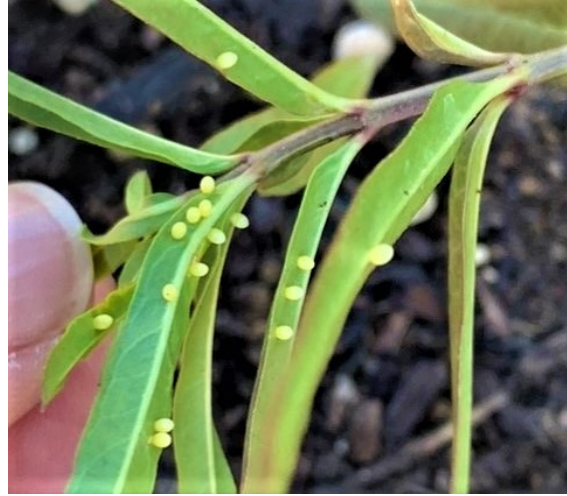
Figure 3. High-density oviposition by monarchs on Asclepias fascicularis at Rinconada Community Garden, Palo Alto, CA, USA, 23 February 2021.